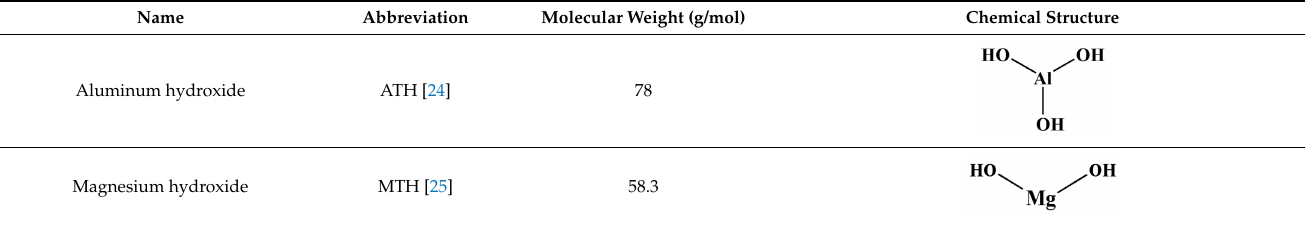
Table 1. PU with additive flame